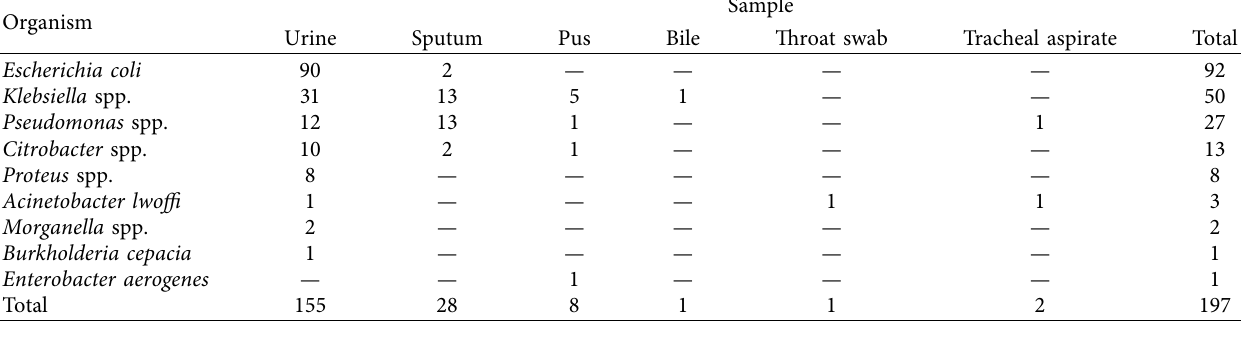
Table 1: Distribution of organisms among different clinical samples. Organism